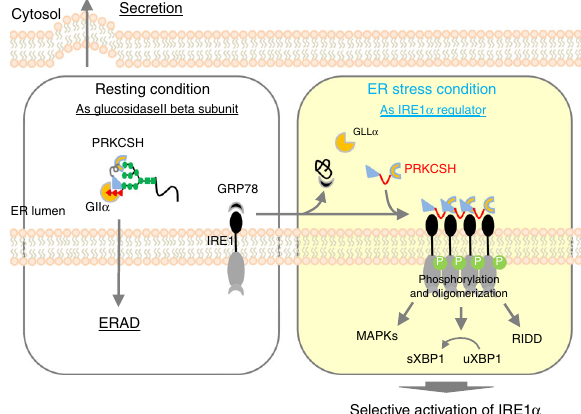
Fig. 9 A proposed model for the dual function of PRKCSH in ER protein quality control. Under resting conditions, PRKCSH functions as the noncatalytic beta subunit of glucosidase II, which catalyzes glucose trimming from newly synthesized glycoproteins and ensures secretion of properly folded glycoproteins and targeting improperly folded glycoproteins for degradation by the ERAD pathway. This is mediated by the interaction of PRKCSH with glucosidase II alpha subunit (GII α ) through the G2B domain and with mannose residues of glycoproteins through the MRH domain of PRKCSH. Under ER stress, PRKCSH dissociates from the GII α subunit and subsequently associates with IRE1 α through its internal E/P domain, which leads to autophosphorylation and oligomerization of IRE1 α followed by RNase-mediated splicing of XBP1 and kinase domain-mediated phosphorylation of MAPKs, thereby selectively promoting activation of the IRE1 α signaling branch. Findings from this study are shown on a yellow background, whereas the known function of PRKCSH is shown on a